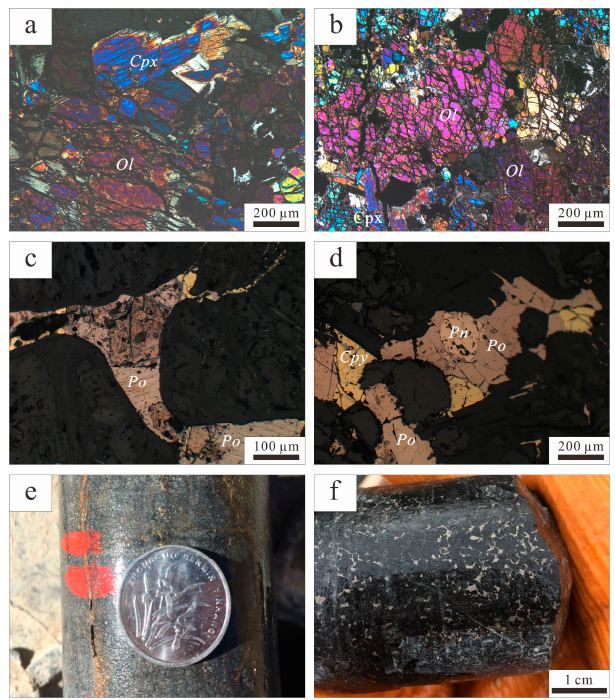
Figure 3. Hand specimens and photomicrographs of typical lithofacies from the Gayahedonggou Cu-Ni deposit. ( a ) Olivine-bearing clinopyroxenite; ( b ) Wehrlite; ( c ) Interstitial sulfide aggregates between the olivine crystals; ( d ) Wehrlite, disseminated sulfide structure; ( e , f ) Disseminated sulfides hosted in wehrlite from drill core ZK0004. Mineral abbreviations: Ol = olivine, Cpx = clinopyroxene, Pn = pentlandite, Po = pyrrhotite, and Cpy = chalcopyrite.